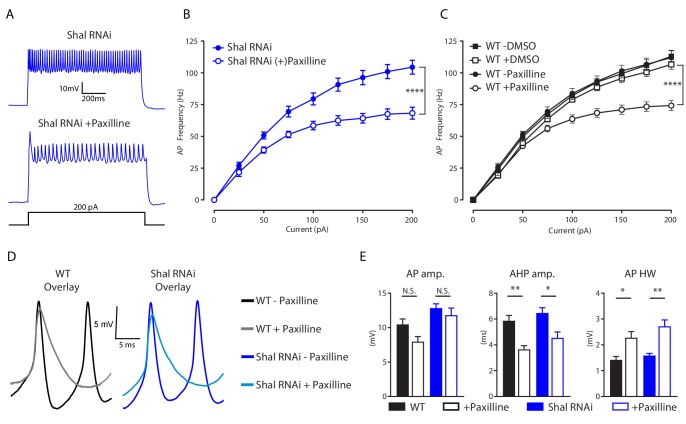
IKCa is necessary to maintaining WT firing rates.(A) Representative voltage traces from Shal-RNAi and Shal-RNAi +Paxilline at 200 pA step current injection. (B) F-I curves of Shal-RNAi at baseline (filled circles) and Shal-RNAi +Paxilline (open circles), paired recordings, n = 8. (C) F-I curves of WT at baseline (filled circles) and WT + Paxilline (open circles), paired recordings, n = 10; WT at baseline (filled squares) and WT + DMSO (open squares), paired recordings, n = 6. Paxilline was dissolved in DMSO. (D) Example action potential waveforms for WT ± Paxilline overlayed (black, grey) and Shal-RNAi ± Paxilline overlayed (dark blue, light blue). (E) Action potential waveform quantification. Mean ± S.E.M.; *p≤0.05; **p<0.01; ***p<0.0001 ****p≤0.0001. N.S., not significant; two-way RM-ANOVA (F-I curves), one-way ANOVA (AP waveform comparisons) with Tukey post-hoc tests.